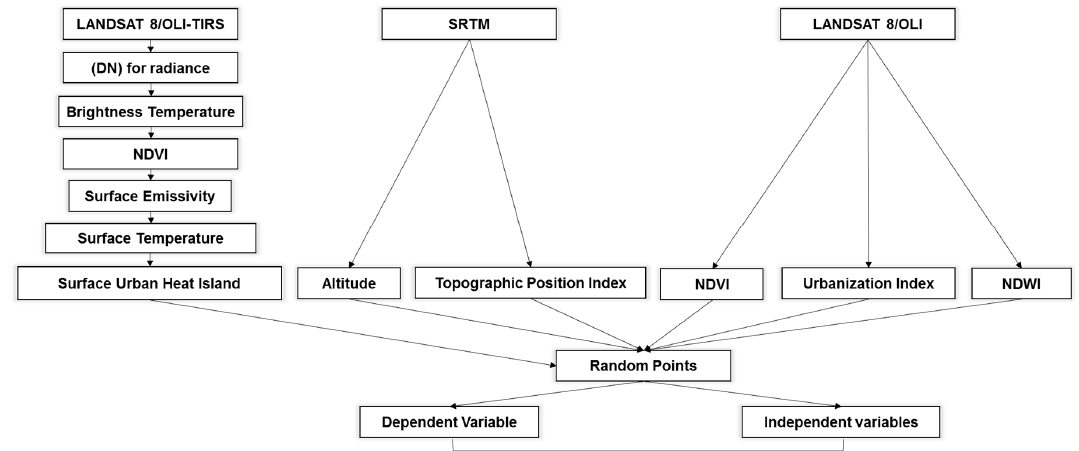
Figure 2. Methodological procedure for the calculation and analysis of surface urban heat island (SUHI).